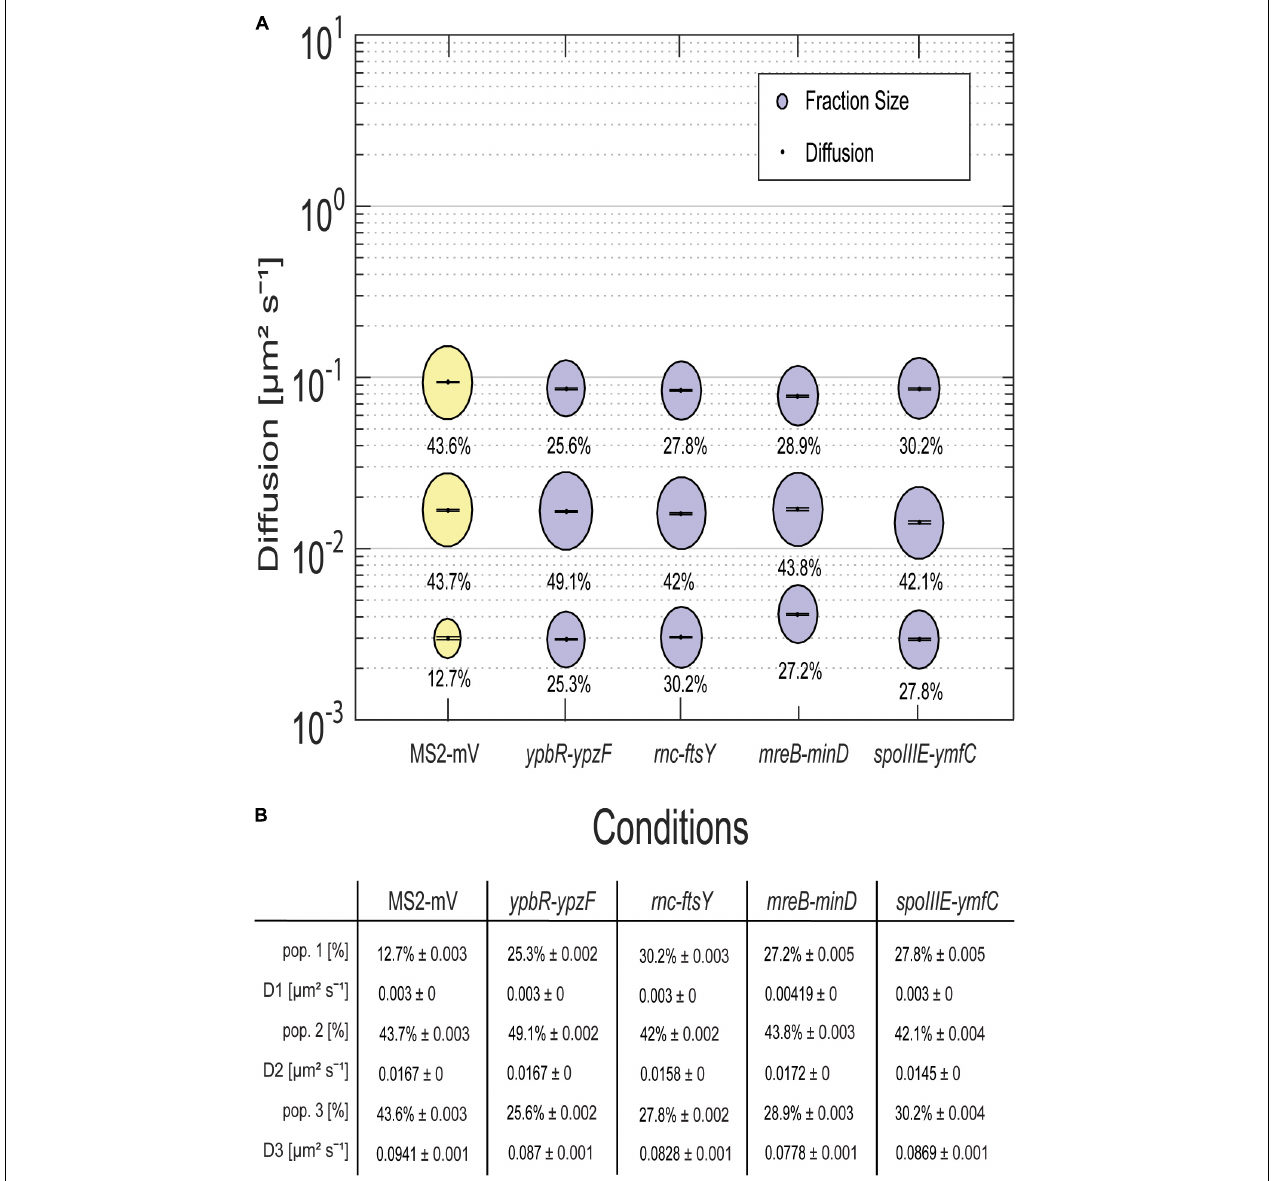
FIGURE 3 | Dynamics of different mRNAs for soluble, membrane, and membrane-associated proteins in comparison to MS2-mVenus. For the determination of the diffusive coefficient and the fraction size, SQD was used. (A) The bubble plot shows the size of the fraction where each bubble is proportional to the area of its corresponding diffusion coefficients. MS2-mVenus alone is shown in yellow, whereas the different mRNAs are shown in purple. Table (B) states the SQD